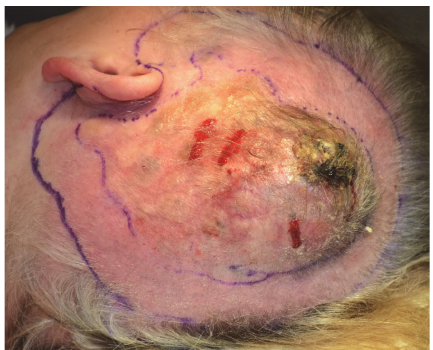
Figure 1: Primary tumour at time of resection.